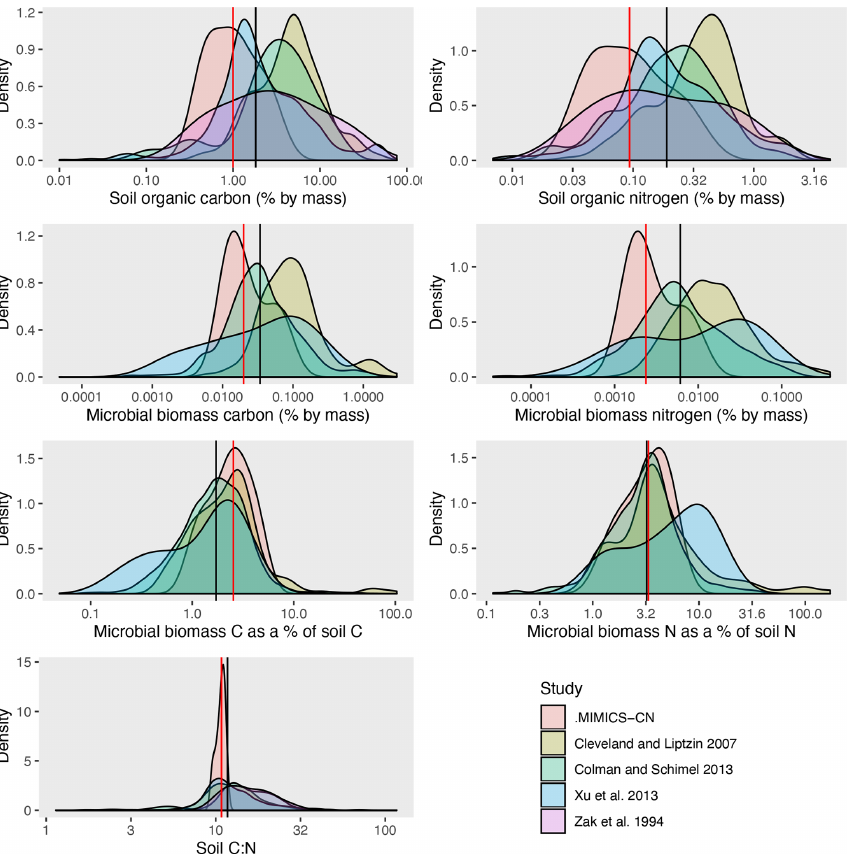
Figure 5. Distributions of MIMICS-CN estimates of steady-state values for a variety of soil pools and fluxes, compared against observed ranges from several continent-wide data synthesis studies. Black lines show the median value across all observations; red lines show median value of MIMICS-CN